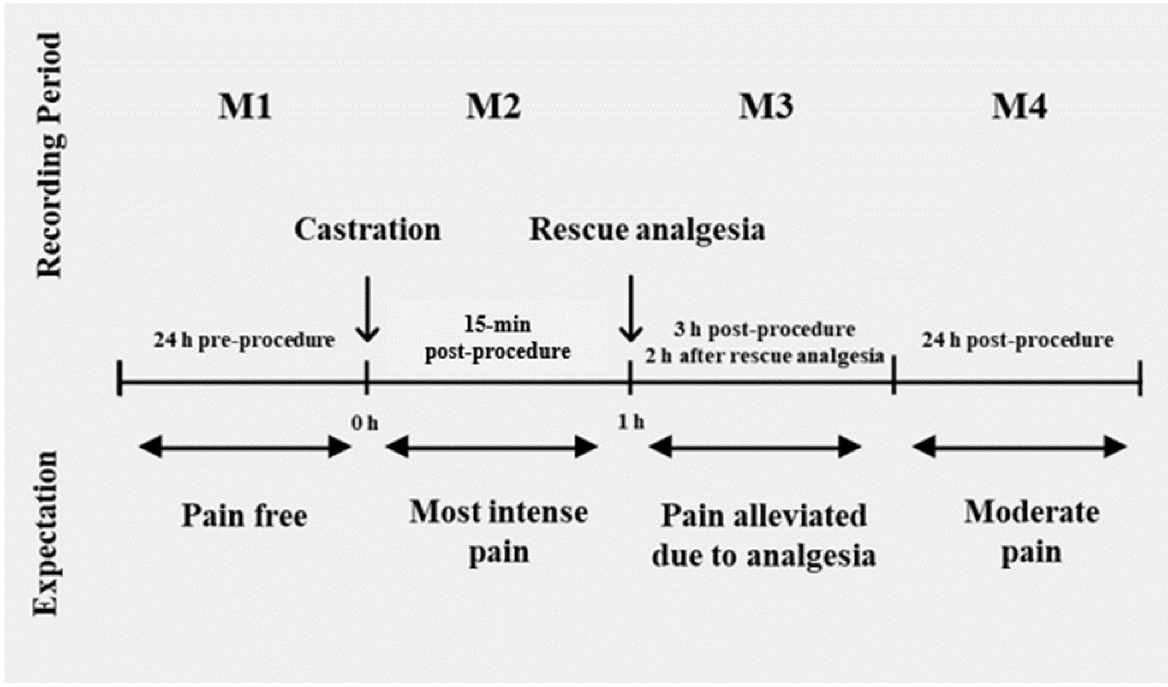
Fig 2. Timeline of the periods of observations used for pain scale